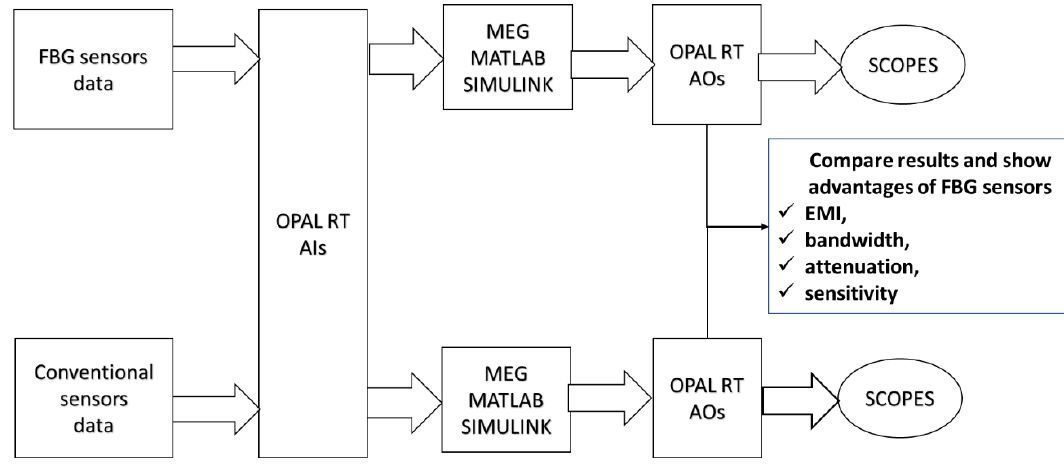
Figure 4. Realtime simulation methodology.